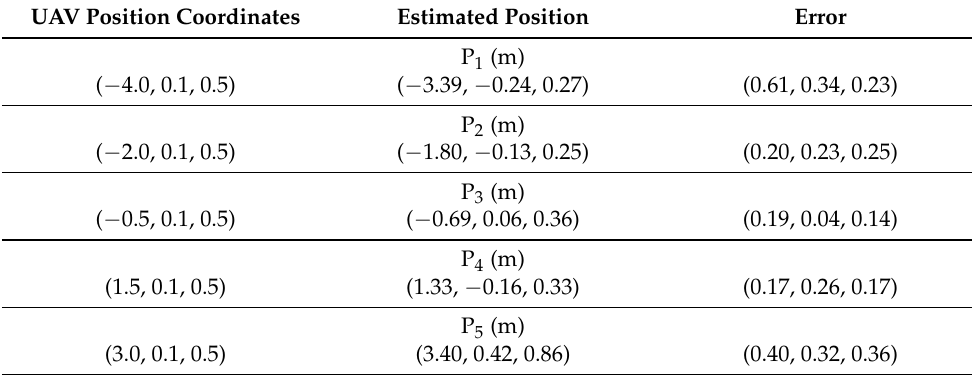
Table 1. MLE target estimation